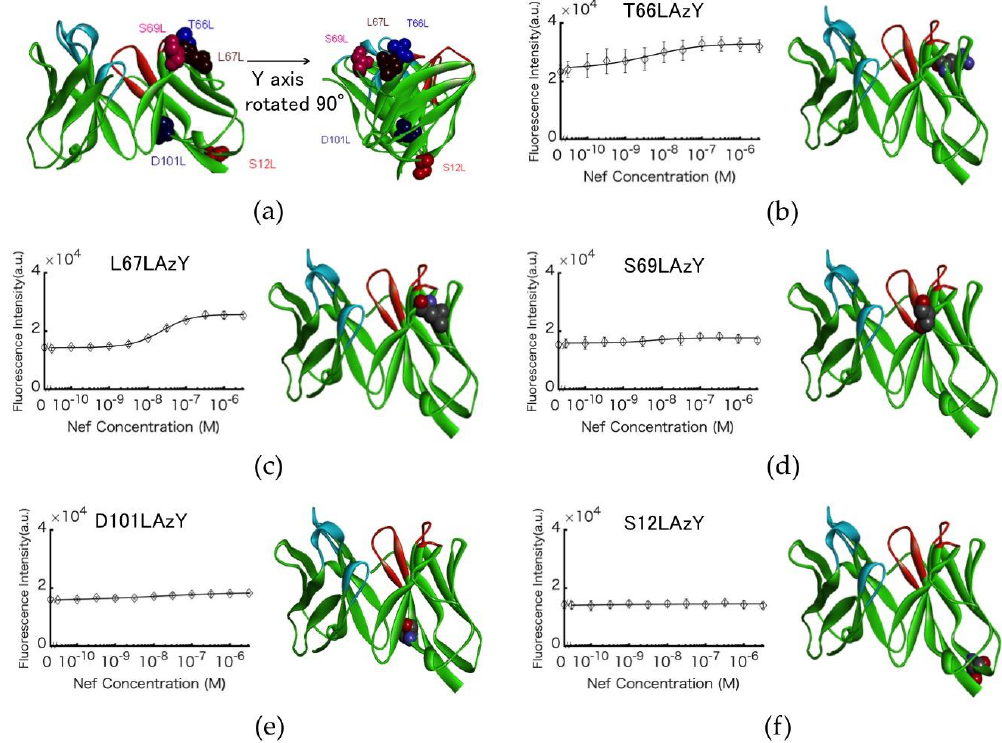
Figure 3. Antigen-dependent enhancement of Nef Q-body fluorescence. ( a ) Position of the mutated residues of the anti-Nef antibody. ( b – f ) Schematic illustration of the structure of the Nef Q-body (right). Titration curves of the normalized fluorescence intensity of the Nef Q-body (left). Error bars represent ±1 S.D. (n = 3).